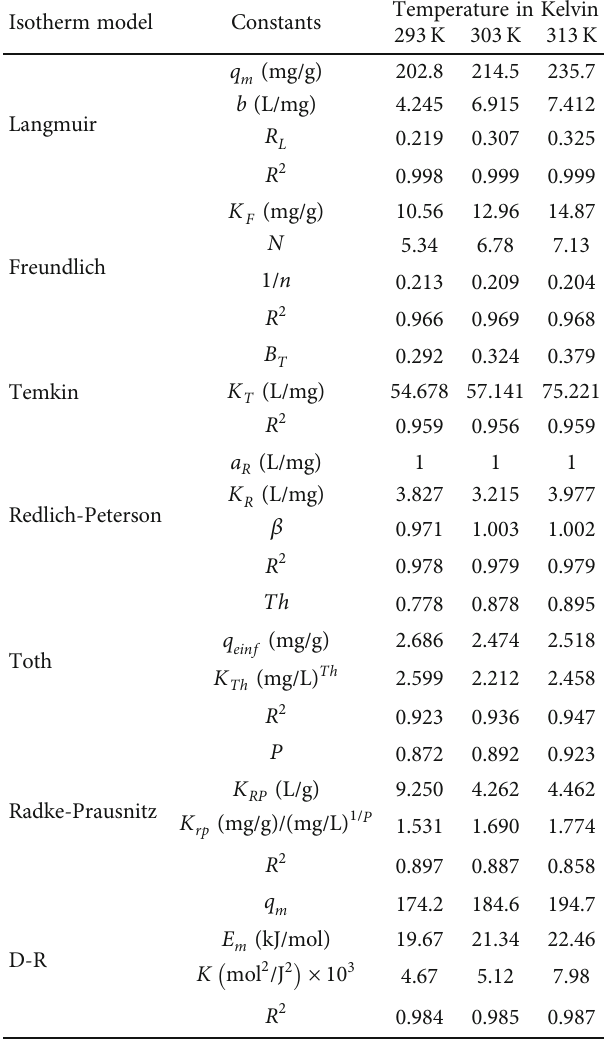
Table 5: Isotherm constants for CV sorption onto ACMAS. Isotherm